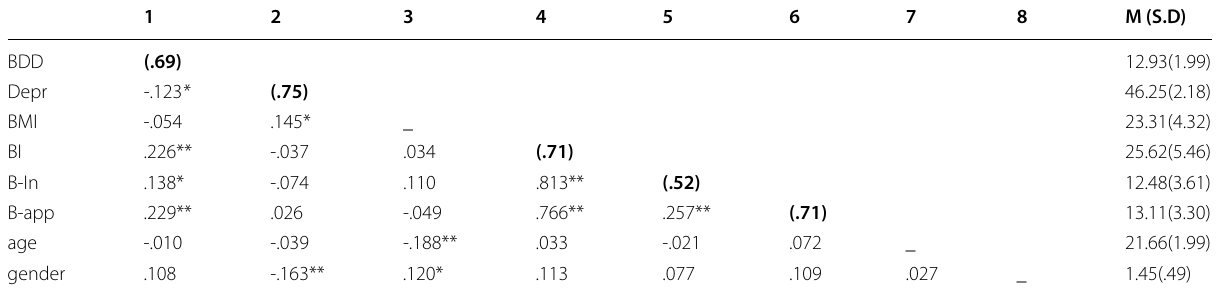
Table 1 Mean, standard deviation, and zero-order correlations between body dysmorphic disorder, body image, and demographic variables ( N 281) =